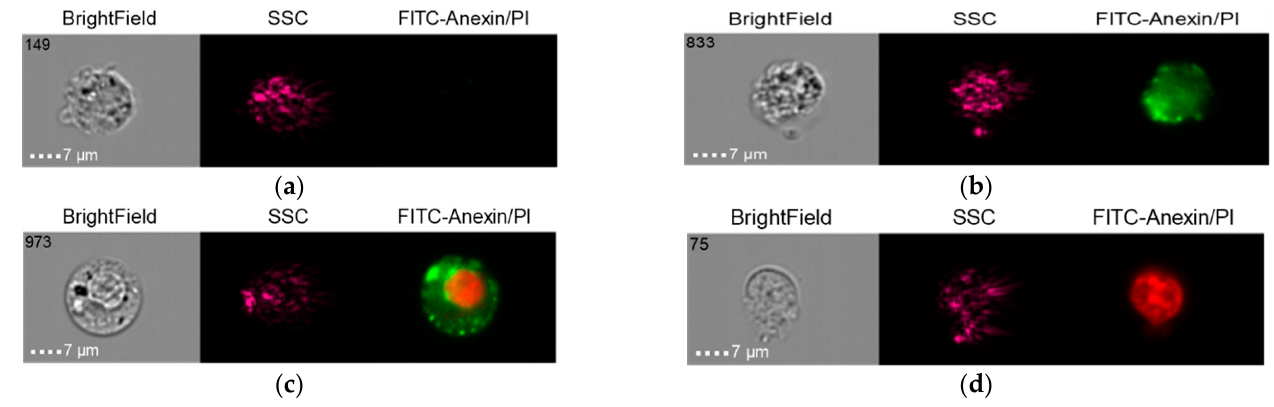
( d ) Figure 13. Live cells ( a ), early apoptosis ( b ), late apoptosis ( c ), necrosis ( d ) after co-culture of Alpha Bio NSMP with THP-1 cell line (Alpha Bio NSMP +THP-1). 2.5.3. Group 3 (Control) The results in the control group when the THP-1 cell line was co-cultured with healthy donor serum (HDS, no previous dental implantation) with Nobel Replace NSMP and lipopolysaccharide (LPS) are shown in Figures 14–16. ( a ) ( b ) ( c ) ( d ) Figure 14. Live cells ( a ), early apoptosis ( b ), late apoptosis ( c ), necrosis ( d ) after co-culture of THP- 1 cell line with healthy donor serum without previous dental implantation (HDS + THP-1).